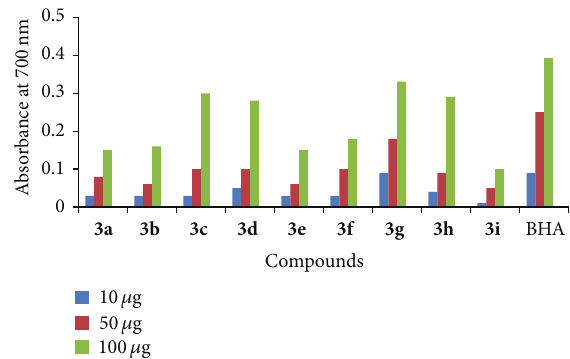
Figure 3: Ferric reducing antioxidant power activity of 3a–i .